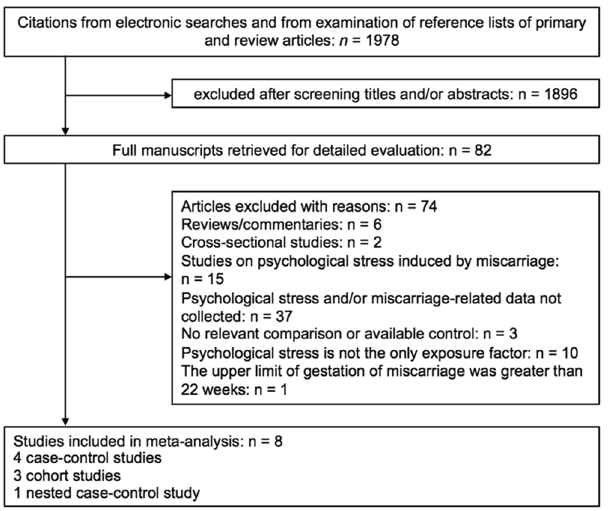
Figure 1. Flow diagram illustrating the selection procedure of relevant articles reporting on the association between psychological stress and